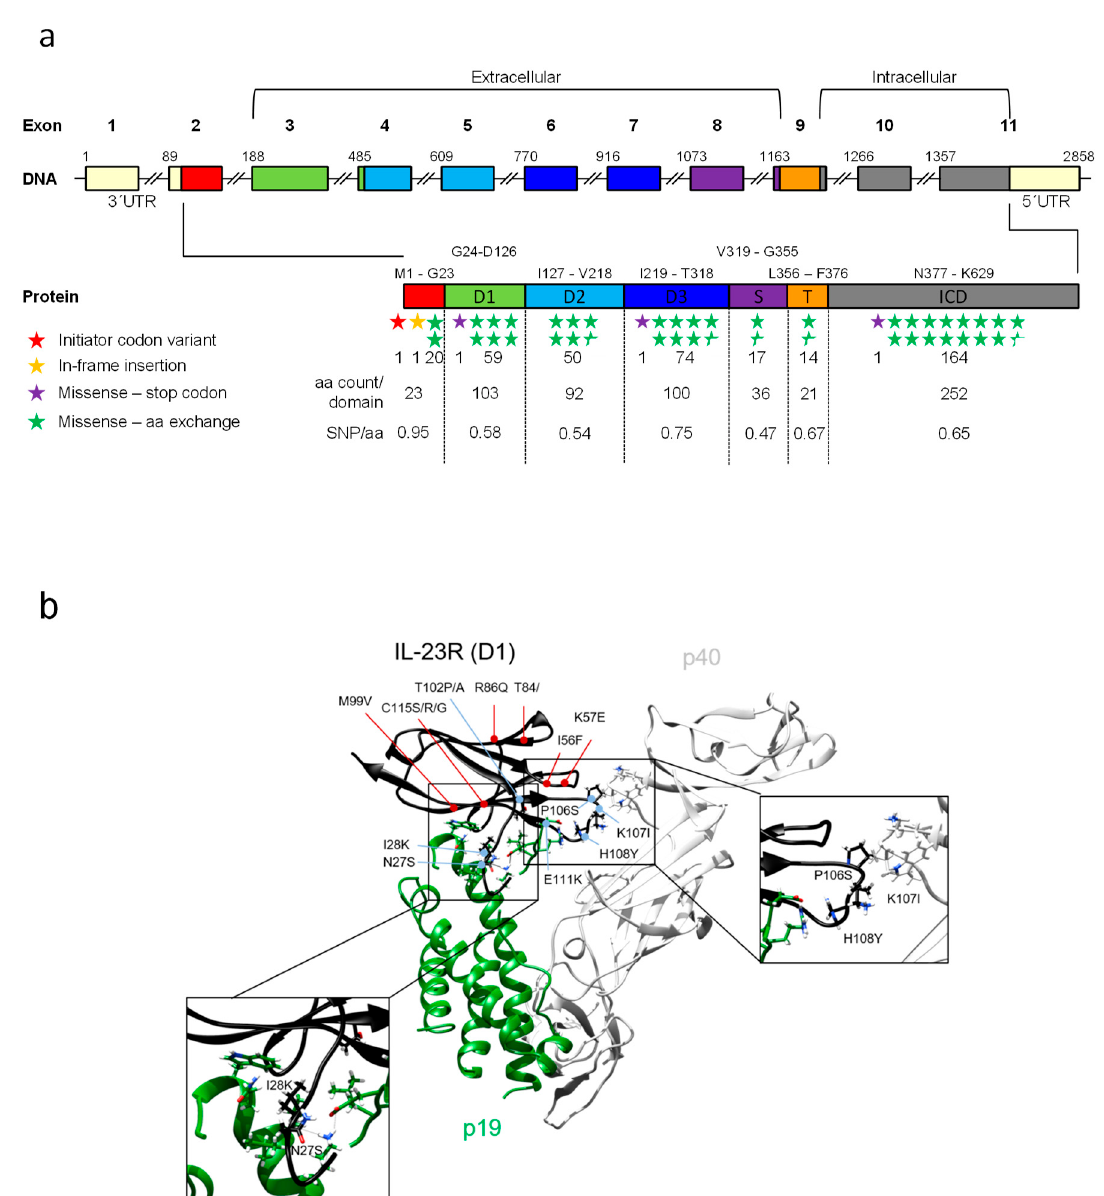
Figure 5. Single nucleotide polymorphisms of human IL-23R. ( a ) Schematic illustration of the intron-exon-structure and the corresponding translated human IL-23R protein. mRNA and amino acid numbers are given for exons/intron and domain borders, respectively (red: signal peptide; green: D1—domain 1; light blue: D2—domain 2; dark blue: D3—domain 3; purple: S—stalk region; orange: T—transmembrane domain; grey: ICD—intracellular domain). Moreover, number of missense mutations are included by colored stars (red star: initiator codon variant, yellow star: in-frame insertion, purple star: missense stop codon, green star: missense amino acid exchange). ( b ) Structure of hIL-23:hIL-23R D1 (PDB 5MZV). IL-23R SNPs unlikely to directly affect the site 3 interface are indicated in red, residues with potential deleterious effects are highlighted in blue. Sidechains of SNPs within site 3 interface and sidechain residues of IL-23p19 and IL-12p40 within 5 Å distance of these SNPs are displayed. Insets display close-up view of IL-23p19 and IL-12p40 interactions of the IL-23R receptor. Molecular graphics images were produced using the UCSF Chimera package from the Resource for Biocomputing, Visualization, and Informatics at the University of California, San Francisco (supported by NIH P41 RR-01081).